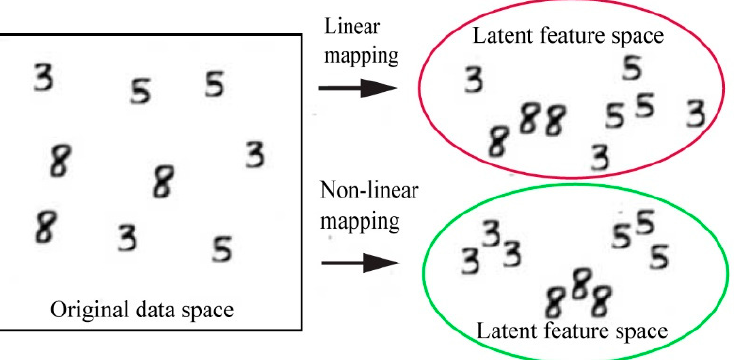
Figure 5. An instance of the clustering layer. The left box shows the original data space where we can see the different positions of digits. Due to huge intra-variance, it seems complicated to perform a clustering task. These digits are mapped to some latent feature spaces. The oval in the upper right corner displays a linear mapping, and the one in the lower right corner shows a nonlinear mapping.